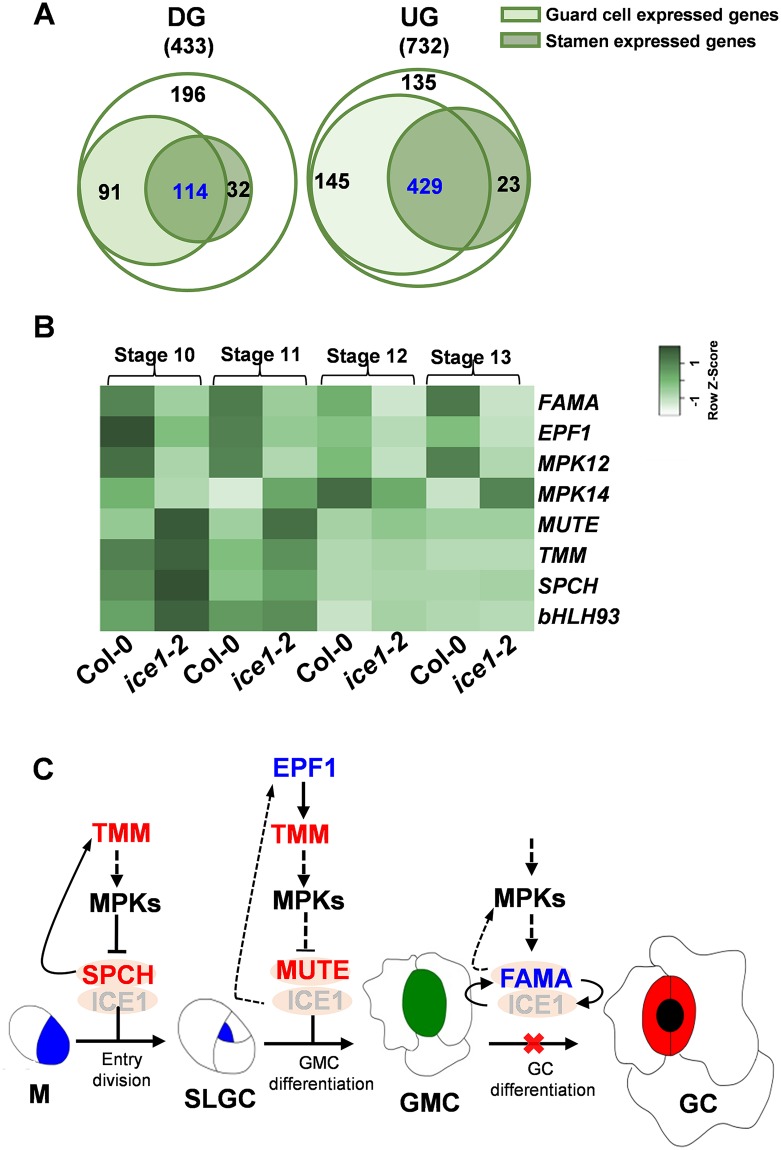
Guard cell expressed genes are overrepresented within ICE1-regulated genes in the anther.(A) Number of down- and up-regulated genes (DG and UG) in anthers at flower stage 9–13 from ice1-2 compared with that in Col-0. The guard cell-expressed genes and the stamen-expressed genes are shown in circles of light green and dark green, respectively. (B) Heat map showing expression patterns of eight leaf stomatal development genes at the flower stage 10–13 in anthers from Col-0 and ice1-2 measured by qRT-PCR. The gene expression profiles were normalized with ACTIN2 gene (AT3G18780) and were plotted using Heatmapper (http://www2.heatmapper.ca/). (C) Regulatory network of stomatal development in the anther. Red shows up-regulated genes and blue shows down-regulated genes in the anther of ice1-2. When ICE1 is knocked-out, the differentiation from guard mother cells (GMCs) to guard cells (GCs) is blocked.